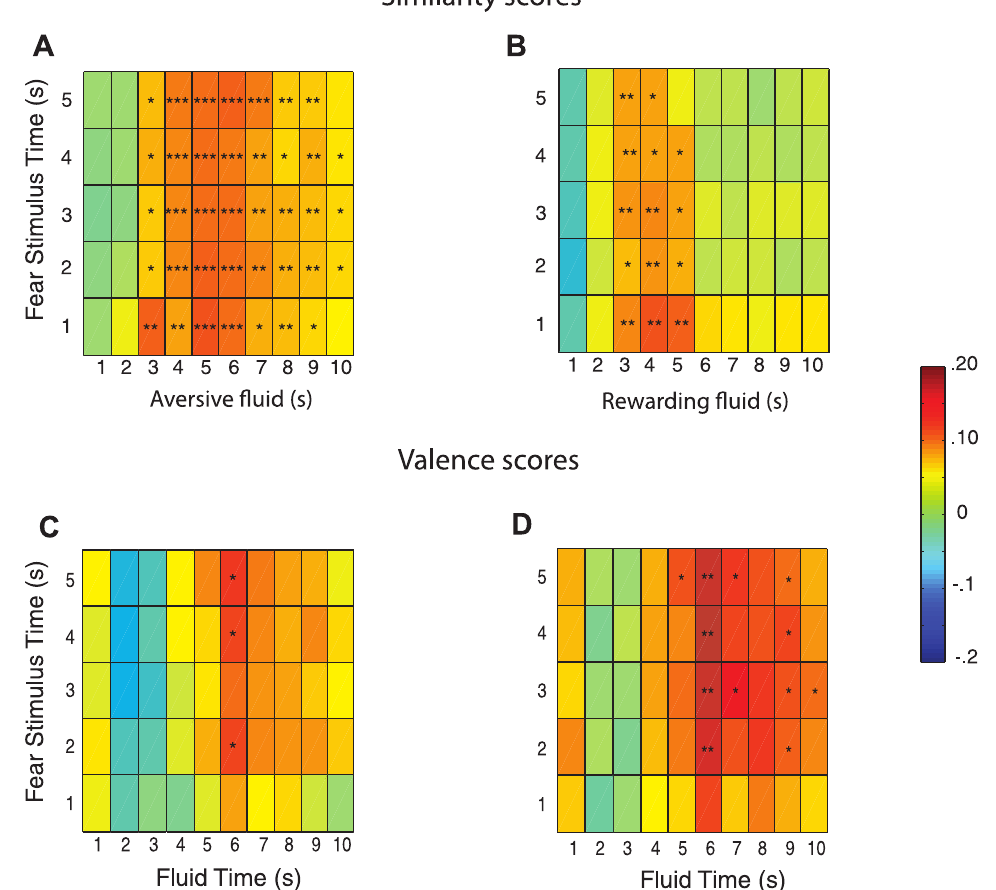
Figure 5. Timing of valence-specific and valence-nonspecific neuronal activity. ( A ) Valence-congruent comparison (n=84 cells). Activity during fear CS and aversive fluid infusion is more similar than expected by chance in many time bins. ( B ) Valence-incongruent comparison (n=84 cells). Activity during fear CS and rewarding fluid infusion is more similar than expected by chance in a smaller number of time bins towards the onset of the rewarding fluid infusion. ( C ) All fear-CS responsive cells (SD and non-SD cells; n=84). Valence-congruent comparison of activity is more similar than valence-incongruent comparison in a small time window. ( D ) Non-SD cells (n=62). Valence-congruent comparison of activity is more similar than valence-incongruent comparison, except towards onset of fear CS and fluid infusions. Scale bar is Z units. * P , .05, ** P , .01, *** P ,